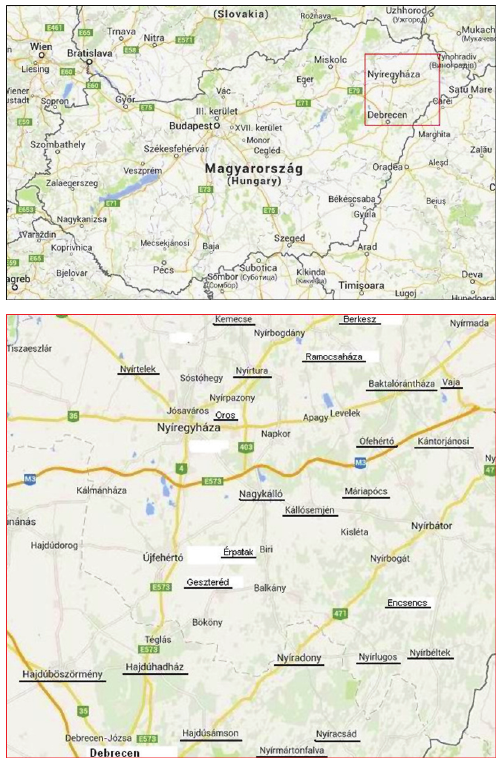
FIGURe 1. Locations of the sampling plots